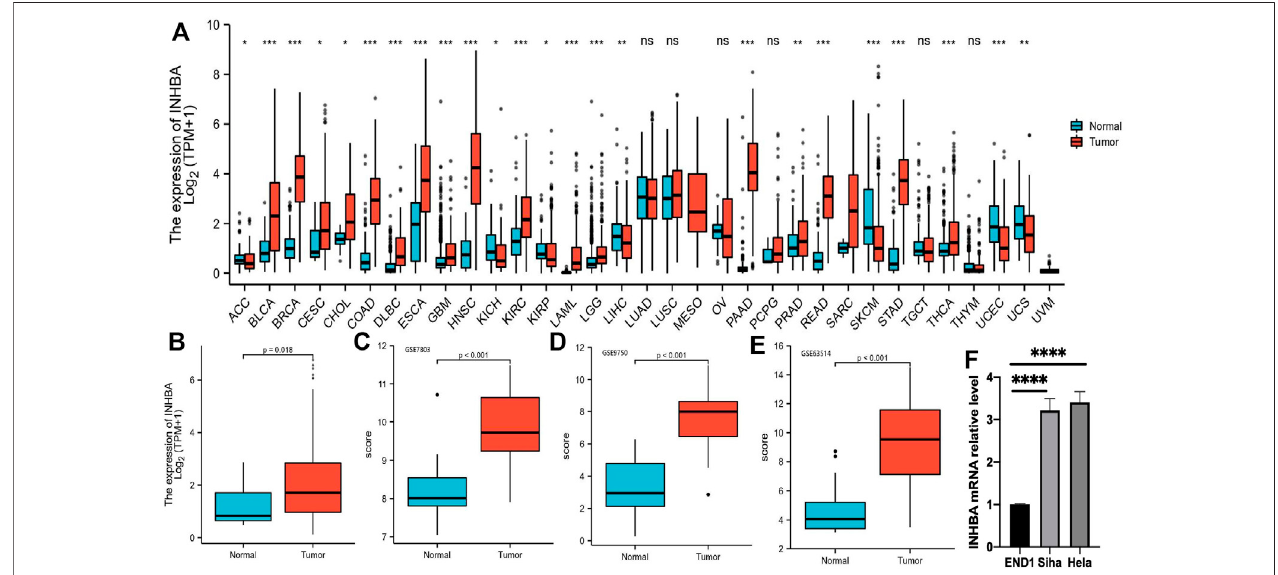
FIGURE1| INHBA expressionlevelanalysisinpan-cancer. (A) INHBA expressioninnormalandtumortissuesinTCGAandGTExdata. (B) Boxplotrepresentation of INHBA expression in cervical cancer tissue. (C – E) INHBA expression in normal cervical tissues and cervical cancer epithelial component from GSE7803, GSE9750 and GSE63514. (F) qRT-PCR analysis of INHBA expression in the indicated cell lines.